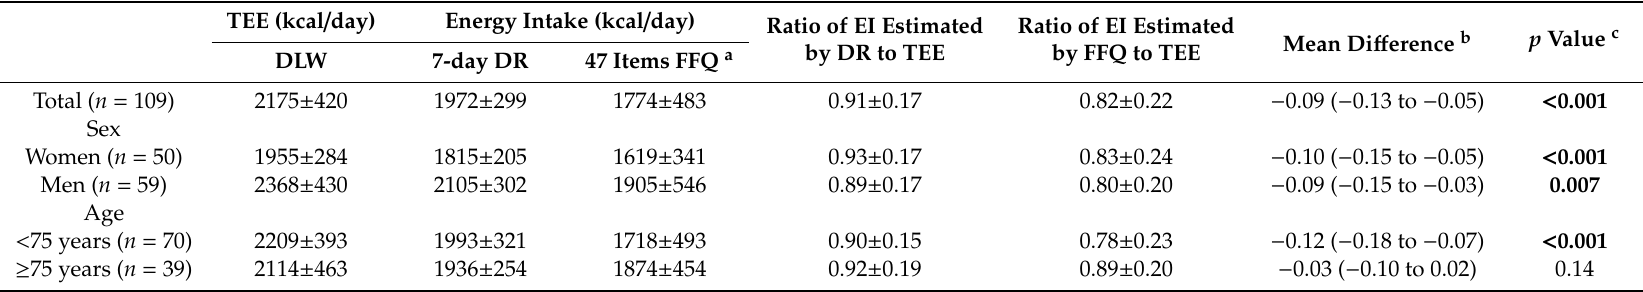
Table 2. Comparison of the total energy expenditure measured by doubly labeled water and energy intake assessed with dietary record and food frequency questionnaire. TEE (kcal / day) Energy Intake (kcal /